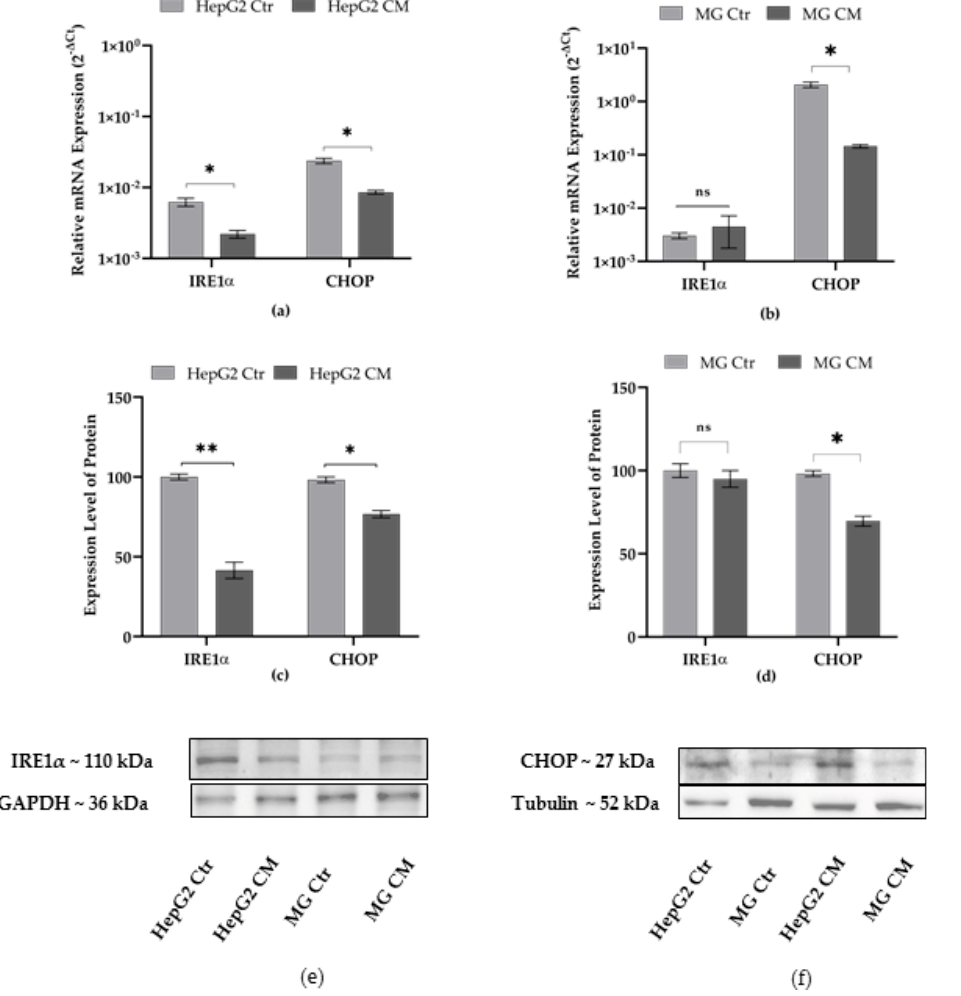
Figure 2. Effect of conditioned media on expression level of IRE1 α and CHOP. Transcript levels in ( a ) HepG2 and ( b ) HMC-III (MG) cells are expressed as 2 −Δ Ct and presented as the mean ± SEM of at least three different experiments. Protein expression level in ( c ) HepG2, ( d ) MG cells; ( e , f ) representative western blots. The protein levels were normalized with GAPDH or Tubulin content; then, for each cell type grown in conditioned medium (CM), data refer to the corresponding control cells grown in their own culture medium (Ctr), and set to 100%. Results are expressed as the mean ± the standard error of three independent experiments. Statistical analysis was performed by using t -test; * p < 0.05, ** p < 0.01; control (Ctr) cells vs. media conditioned treated (CM) cells; ns: not significant p